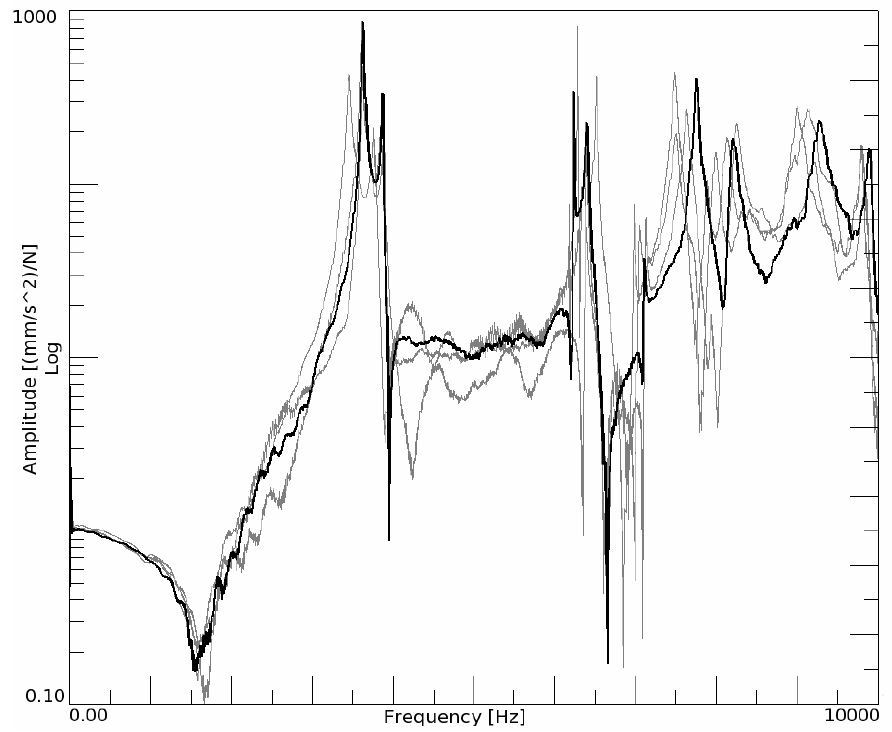
Fig. 12. The results of comparison of FRF measured for calipers obtained using RP mould (thick line) and metal mould (thin